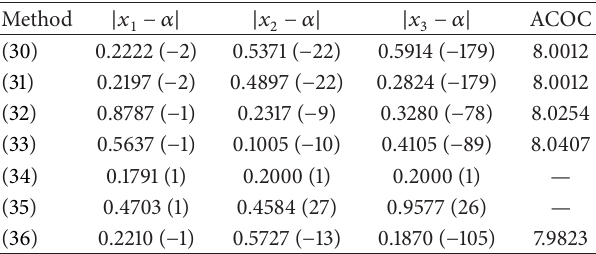
Table 3: Numerical results with 𝑓 3 .